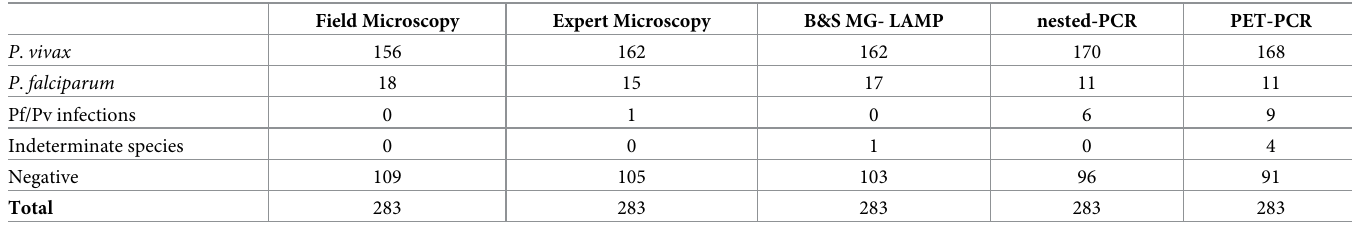
Table 1. Summary of Plasmodium detection results obtained for each method.